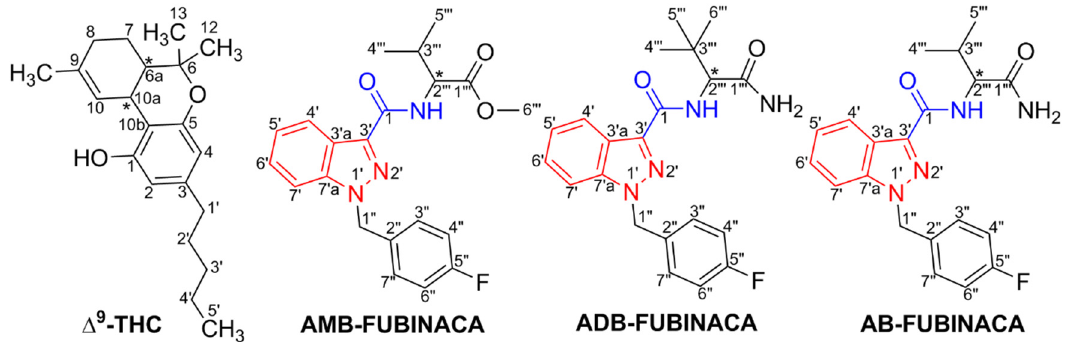
Figure 1. Comparison of the molecular structures of synthetic cannabinoid receptor agonists with that of trans - ∆ 9 -tetrahydrocannabinol ( ∆ 9 -THC). The indazole core is represented in red and the carboxamide link in blue.